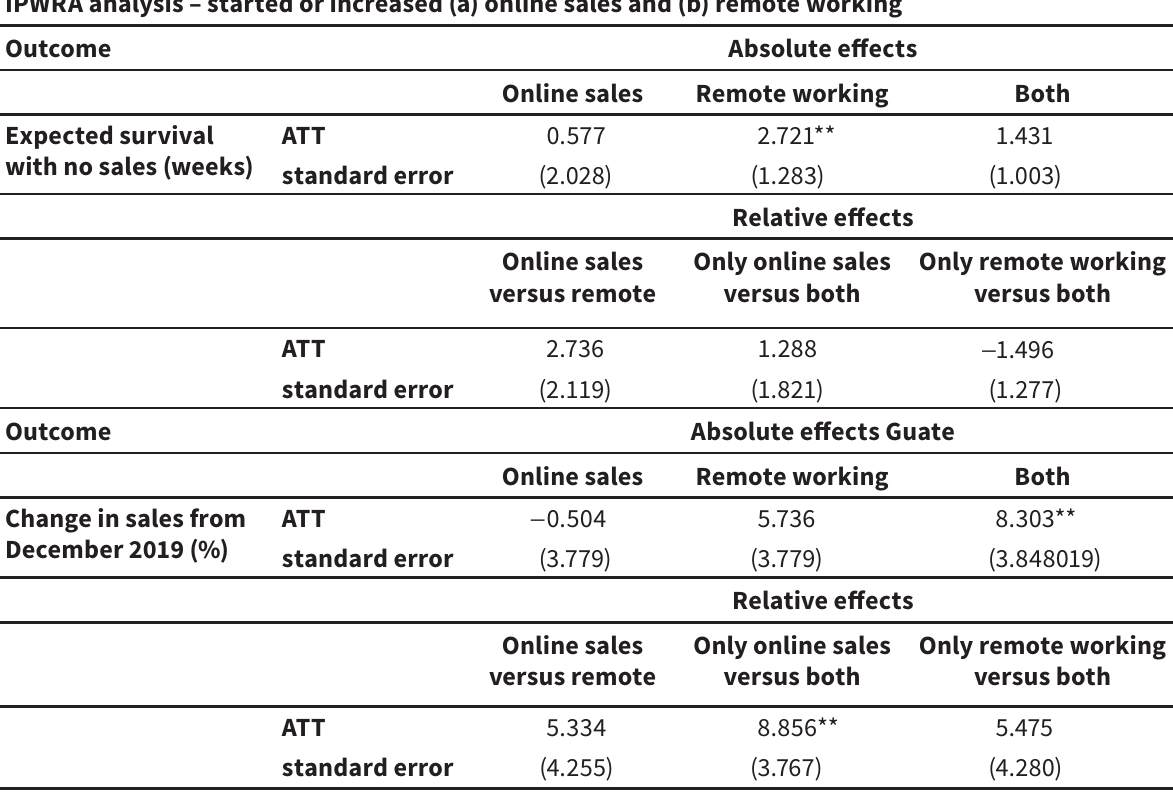
IPWRA analysis for liquidity and